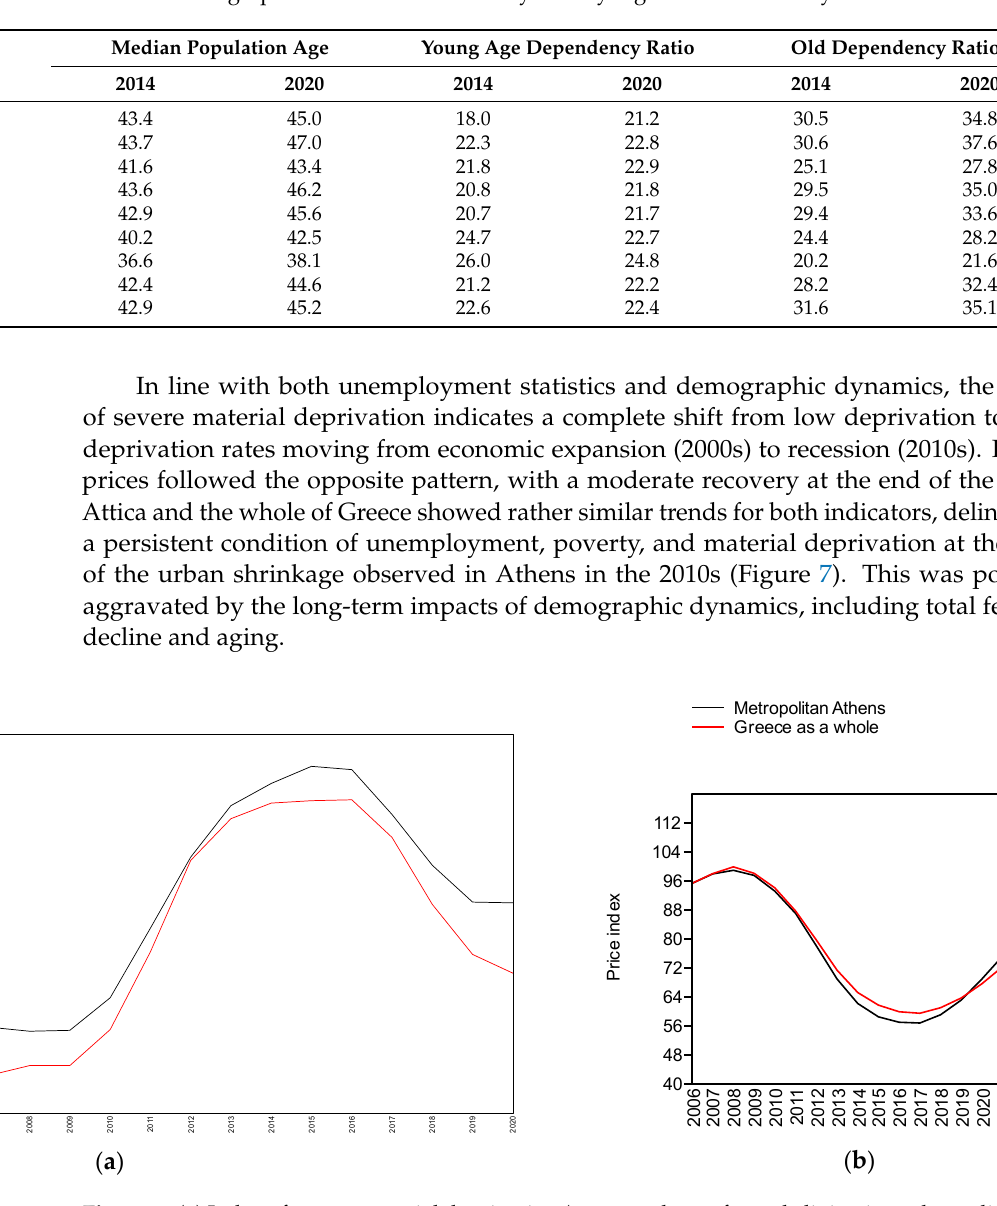
Table 4. Demographic indicators in the study area by regional district and year.